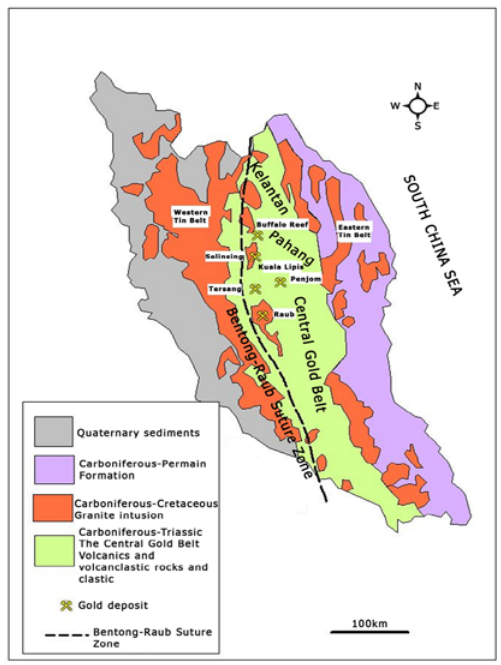
Fig.1. Simplified geological map of the peninsular